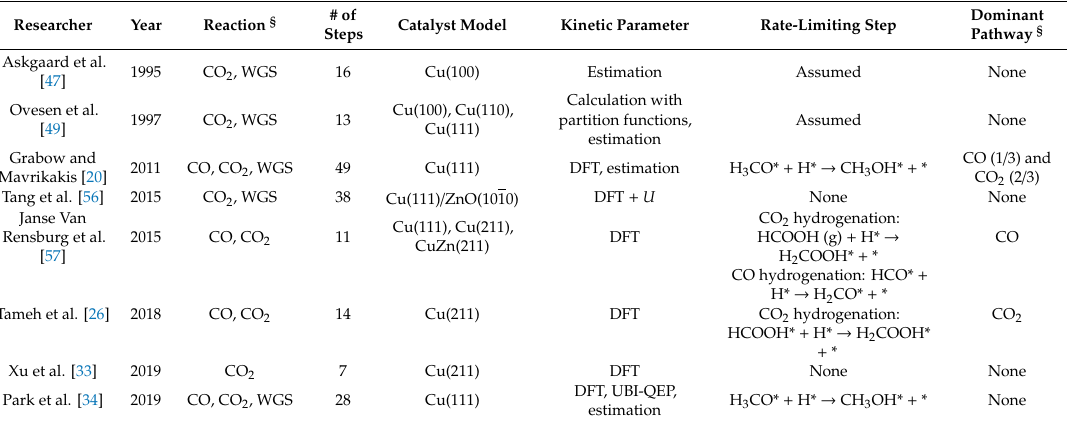
Figure 8. Surface models of PdIn(110) and PdIn(211); the Pd and In atoms are colored in blue and brown, respectively. Reprinted with permission from [73]. Copyright (2019) Royal Society of Chemistry. Table 2. Previous microkinetic studies for MeOH synthesis on Cu-Zn-Al (CZA) catalysts.